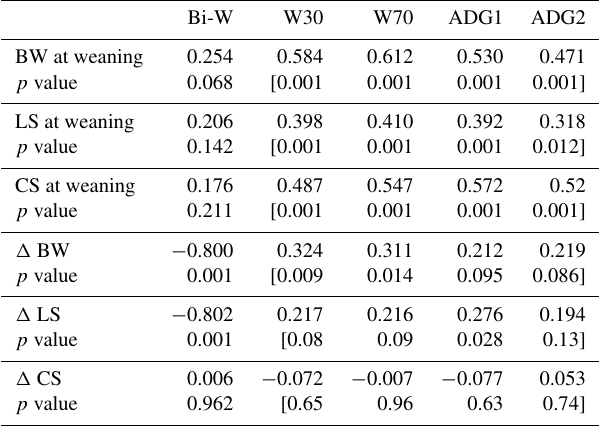
Table 6. Correlation coefficients among ewes’ body weight (BW), lumbar (LS) and caudal (CS) at weaning and lamb growth parame- ters.